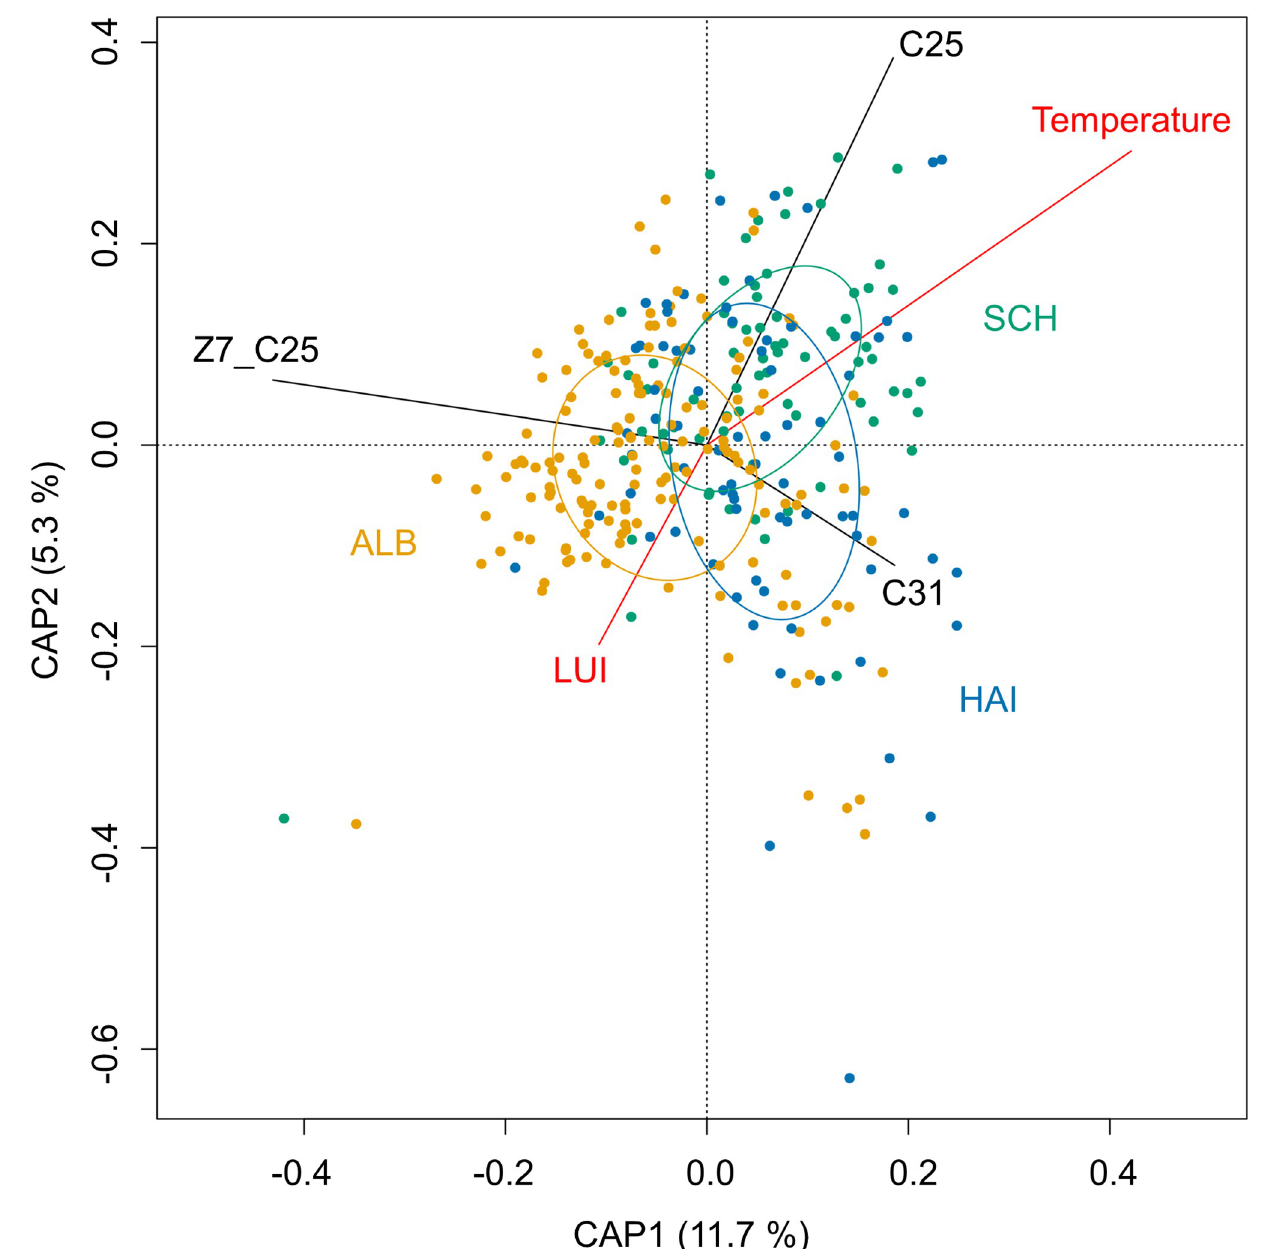
Fig 2. Correlation tri-plot of the first two axes obtained from the distance-based redundancy analysis (dbRDA). The graph shows the relationship between the chemical scent bouquet of lipids on bumblebees and important environmental parameters. Sites are shown as individual plots and ellipses for region groups (ALB: Schwa¨bische Alb, HAI: Hainich-Du¨n, SCH: Schorfheide-Chorin). The explanatory variables temperature and land-use intensity (LUI) are shown as red lines, the three scent compounds with the highest loadings in CAP1 and CAP2, namely (Z)-7-Pentacosene (Z7_C25), Pentacosane (C25), and Hentriacontane (C31), are shown as black